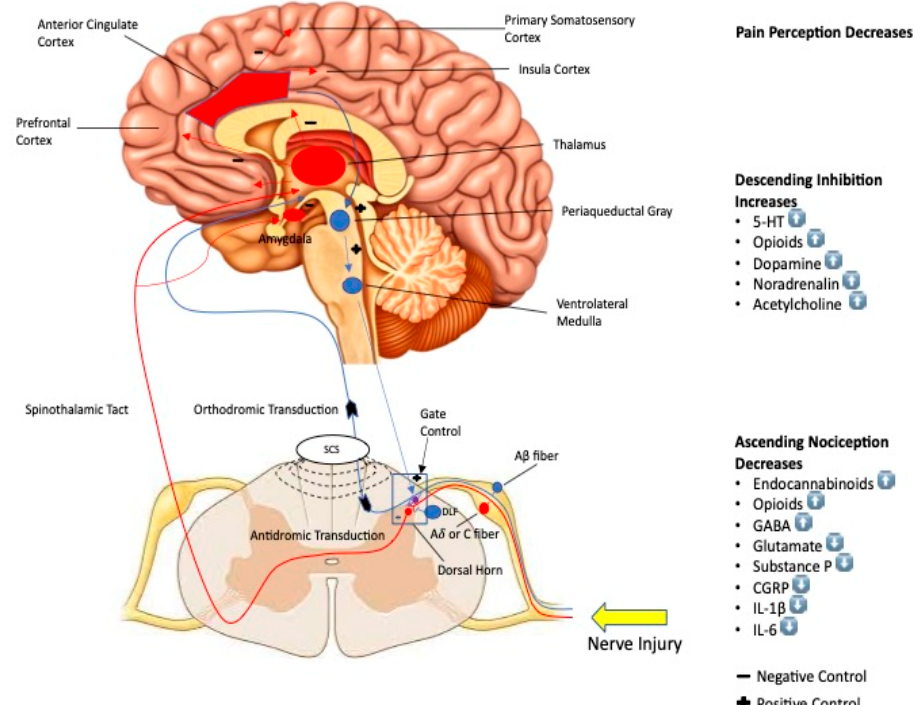
Figure 1. Schematic diagram depicting effects of stimulation on the brain. UP arrow means increase. DOWN arrow means decrease.